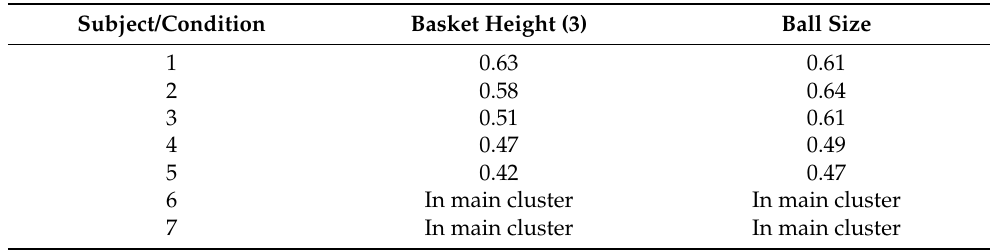
Table 1. Purity in main clusters.